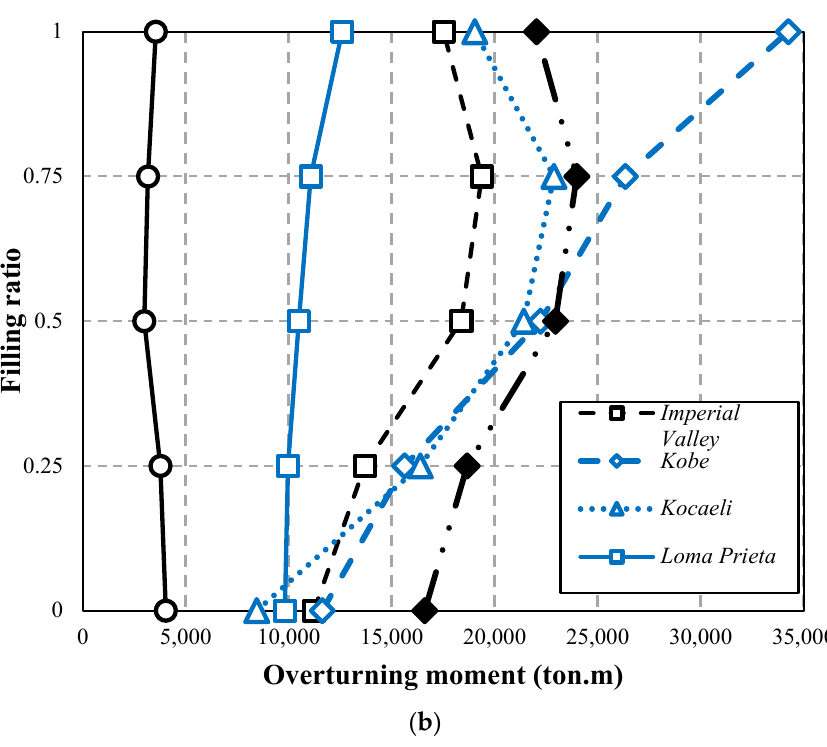
Figure 17. Differences in the overturning moment based on the filling ratio for ( a ) far ‐ fault ground motions and ( b ) near ‐ fault ground motions.